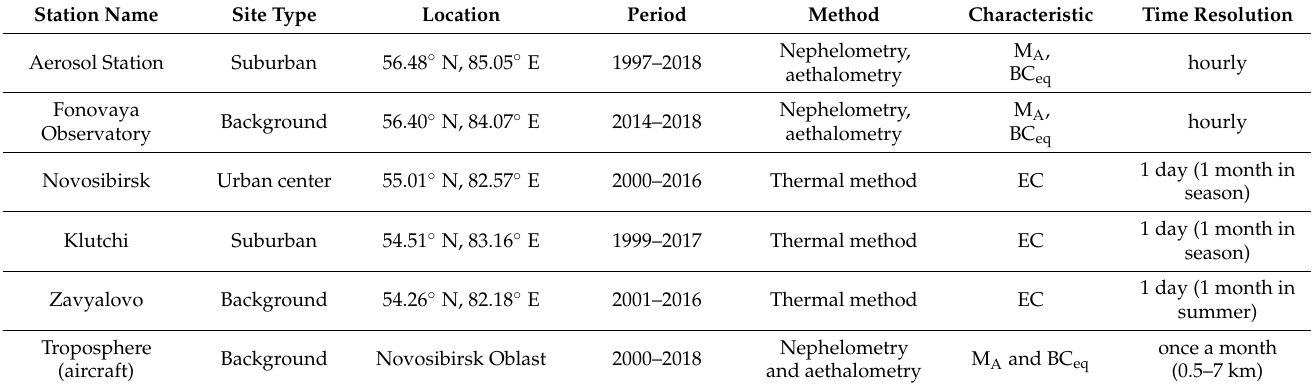
Table 1. Locations and characteristics of monitoring